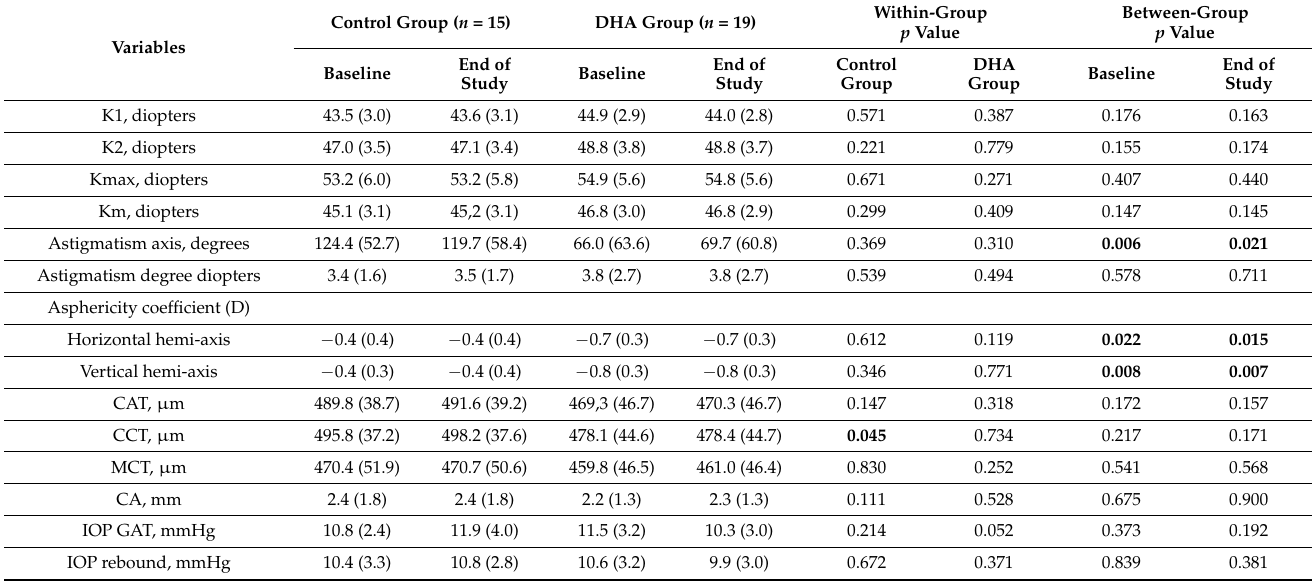
Table 2. Ophthalmological variables at baseline and at the end of the study in patients treated with the DHA supplement and in